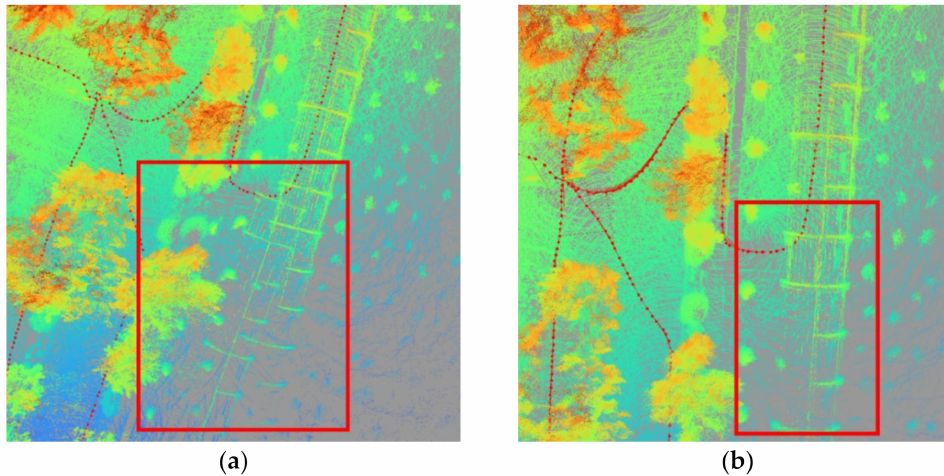
Figure 5. The effect of the manual loop closure method in the outdoor environment: ( a ) odometry drift, and ( b ) corrected point cloud.